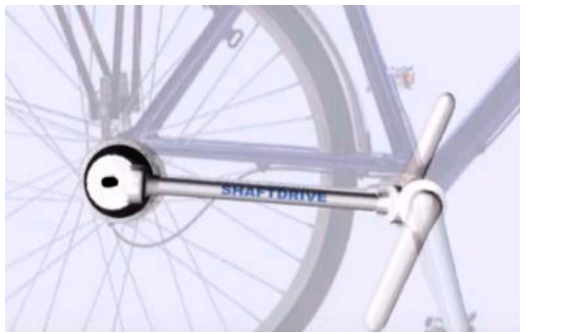
Figure 15. Functioning of a gas spring and positioning in the vehicle.